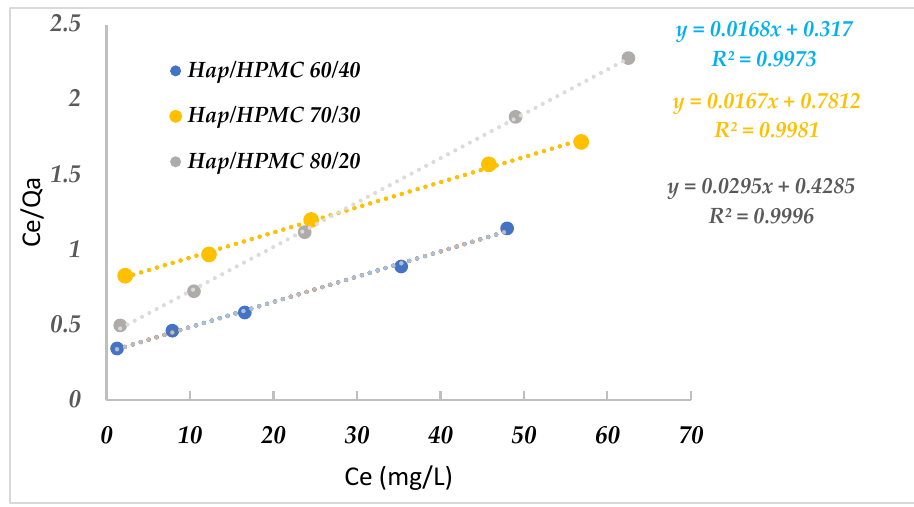
Figure 15. Linearization of the Langmuir equation for the studied adsorbent/adsorbate systems. C e : concentration of adsorbate, Q a : adsorbed quantity.